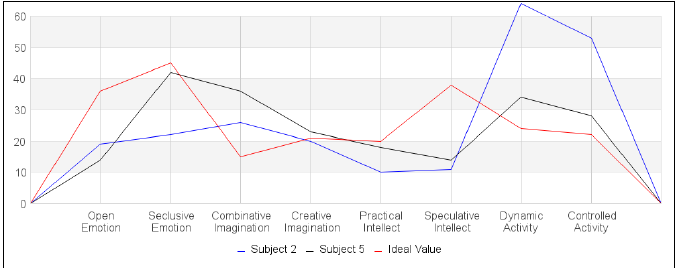
Fig. 6. Comparison graph of the character values of Subject 2 and Subject 5 against the ideal